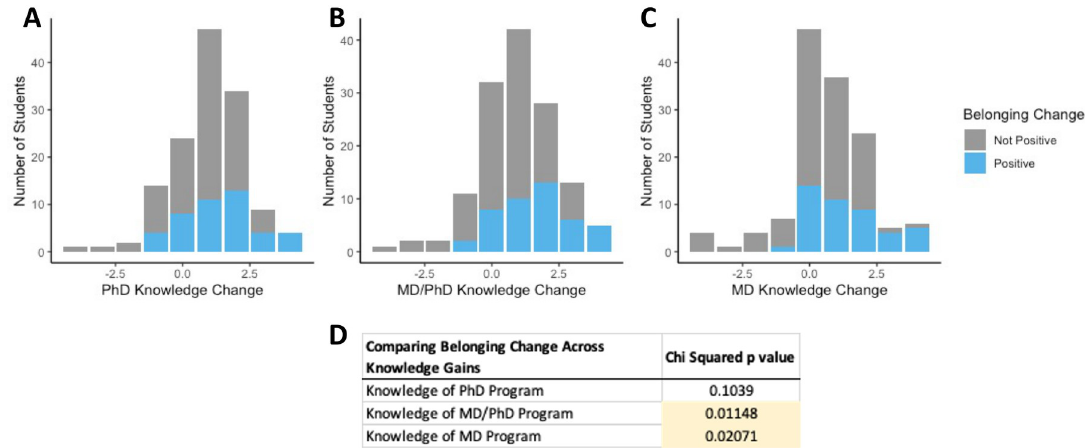
Fig 4. Students who had a positive change in STEMM community belonging had a larger increase in Ph.D., MD, and M.D./PhD program knowledge. (A) Positive STEMM belonging changes have to increase Ph.D. program knowledge, (B) increase M.D./PhD program knowledge, (C) and increase M.D. program knowledge. (D) We compared belonging changes across program knowledge gains and found a positive association between students’ sense of belonging and M.D./PhD and M.D. programs using a chi-squared test of